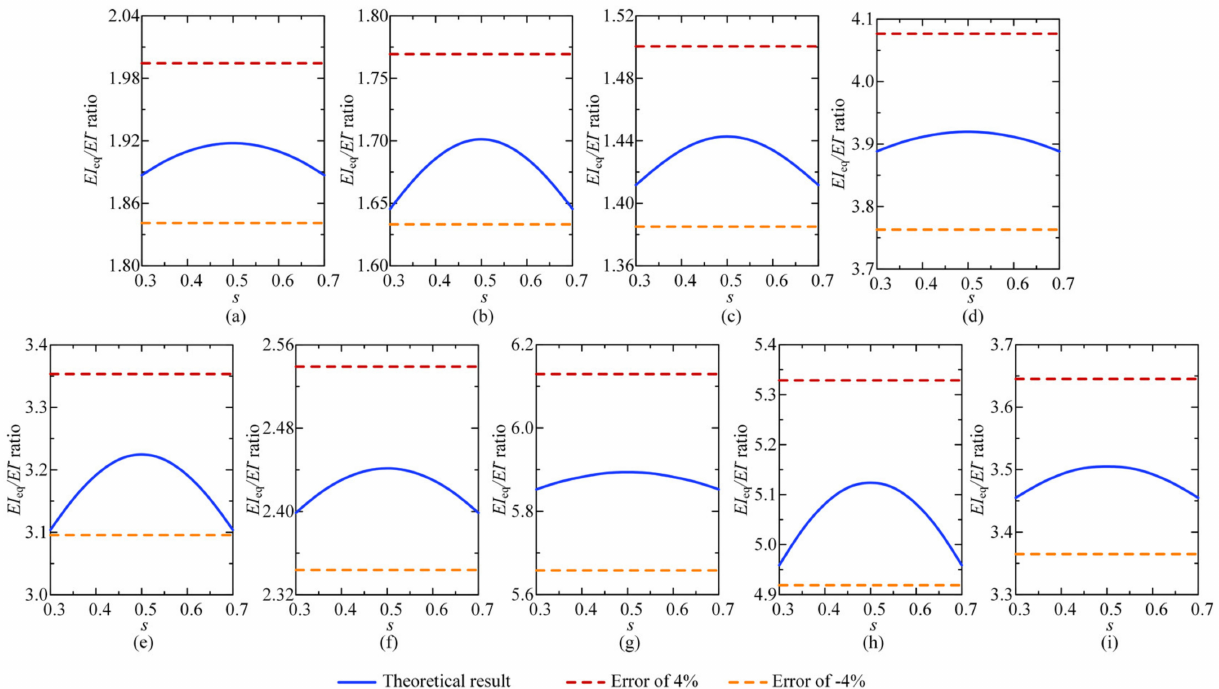
Figure 13. Effects of the unequal distribution of the negative moment regions on the equivalent flexural stiffness. (( a ) α = 2, α cr = 0.2;( b ) α = 2, α cr = 0.3;( c ) α = 2, α cr = 0.4;( d ) α = 4, α cr = 0.12; ( e ) α = 4, α cr = 0.25; ( f ) α = 4, α cr = 0.35; ( g ) α = 6, α cr = 0.1; ( h ) α = 6, α cr = 0.2; ( i ) α = 6, α cr =